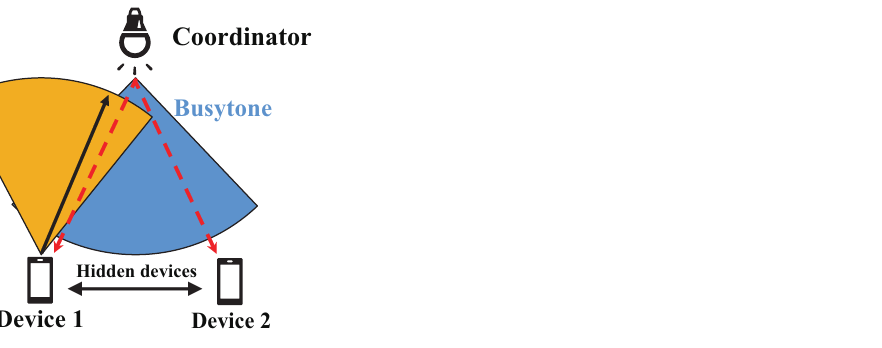
Figure 3. The mechanism of solving the hidden device problem in FD VLC